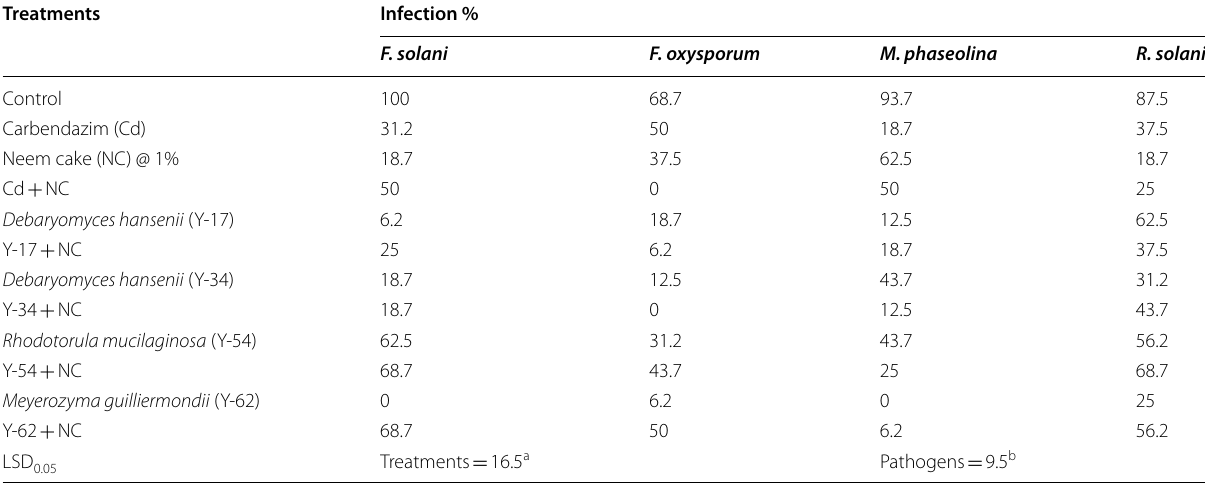
a Mean values in column showing differences greater than LSD valuesare significantly different at p < 0.05 b Mean values in rows showing differencesgreater than LSD values are significantly different at p <